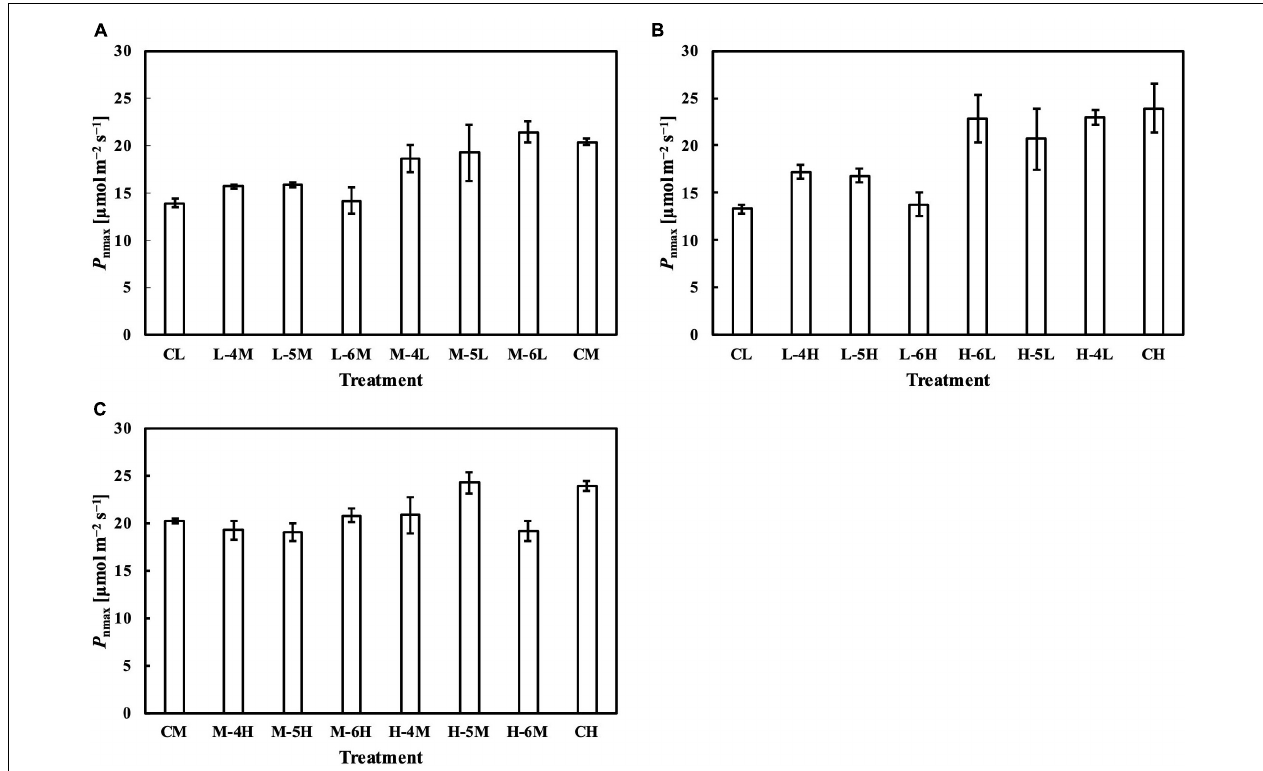
FIGURE 8 | P nmax of leaves subjected to a PPFD for 1 day different from the basal PPFD in the other days. P nmax was measured at ambient CO 2 concentration ( C a ) of 400 µ mol mol − 1 and saturating PPFD of 1,800 µ mol − 1 m − 2 s − 1 . CL and CM: treatments with a constant PPFD of 100 and 400 µ mol m − 2 s − 1 , respectively. The experiment was divided into three groups (A–C) and conducted separately due to limited experimental capacity. Values were means ± standard errors ( n = 3). L–4M: treatment with a PPFD of 400 µ mol m − 2 s − 1 in the fourth day of treatment period and a basal PPFD of 100 µ mol m − 2 s − 1 in the other 5 days. See Supplementary Table 2 for details of